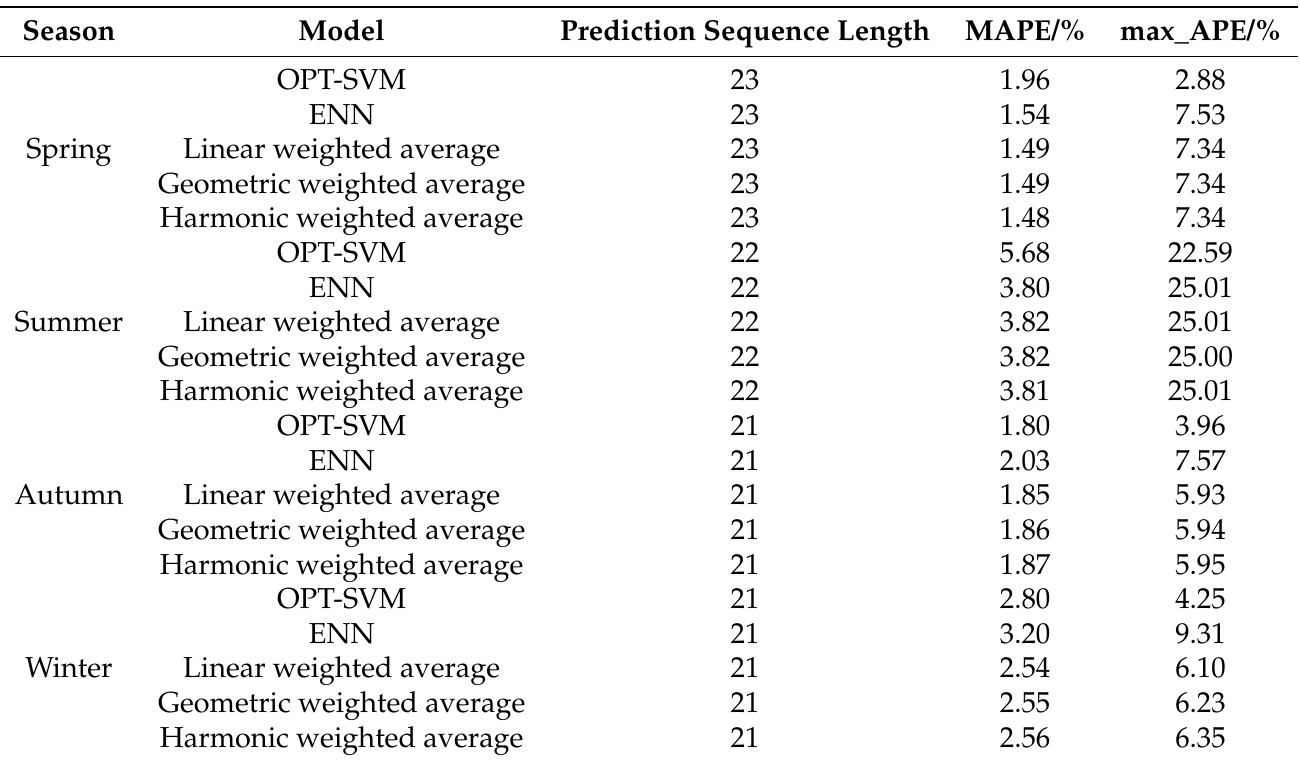
Figure 12. Time-varying weights of individual models through harmonic weighted average daily load forecasting. Table 3. Prediction result comparison of the individual models and combined